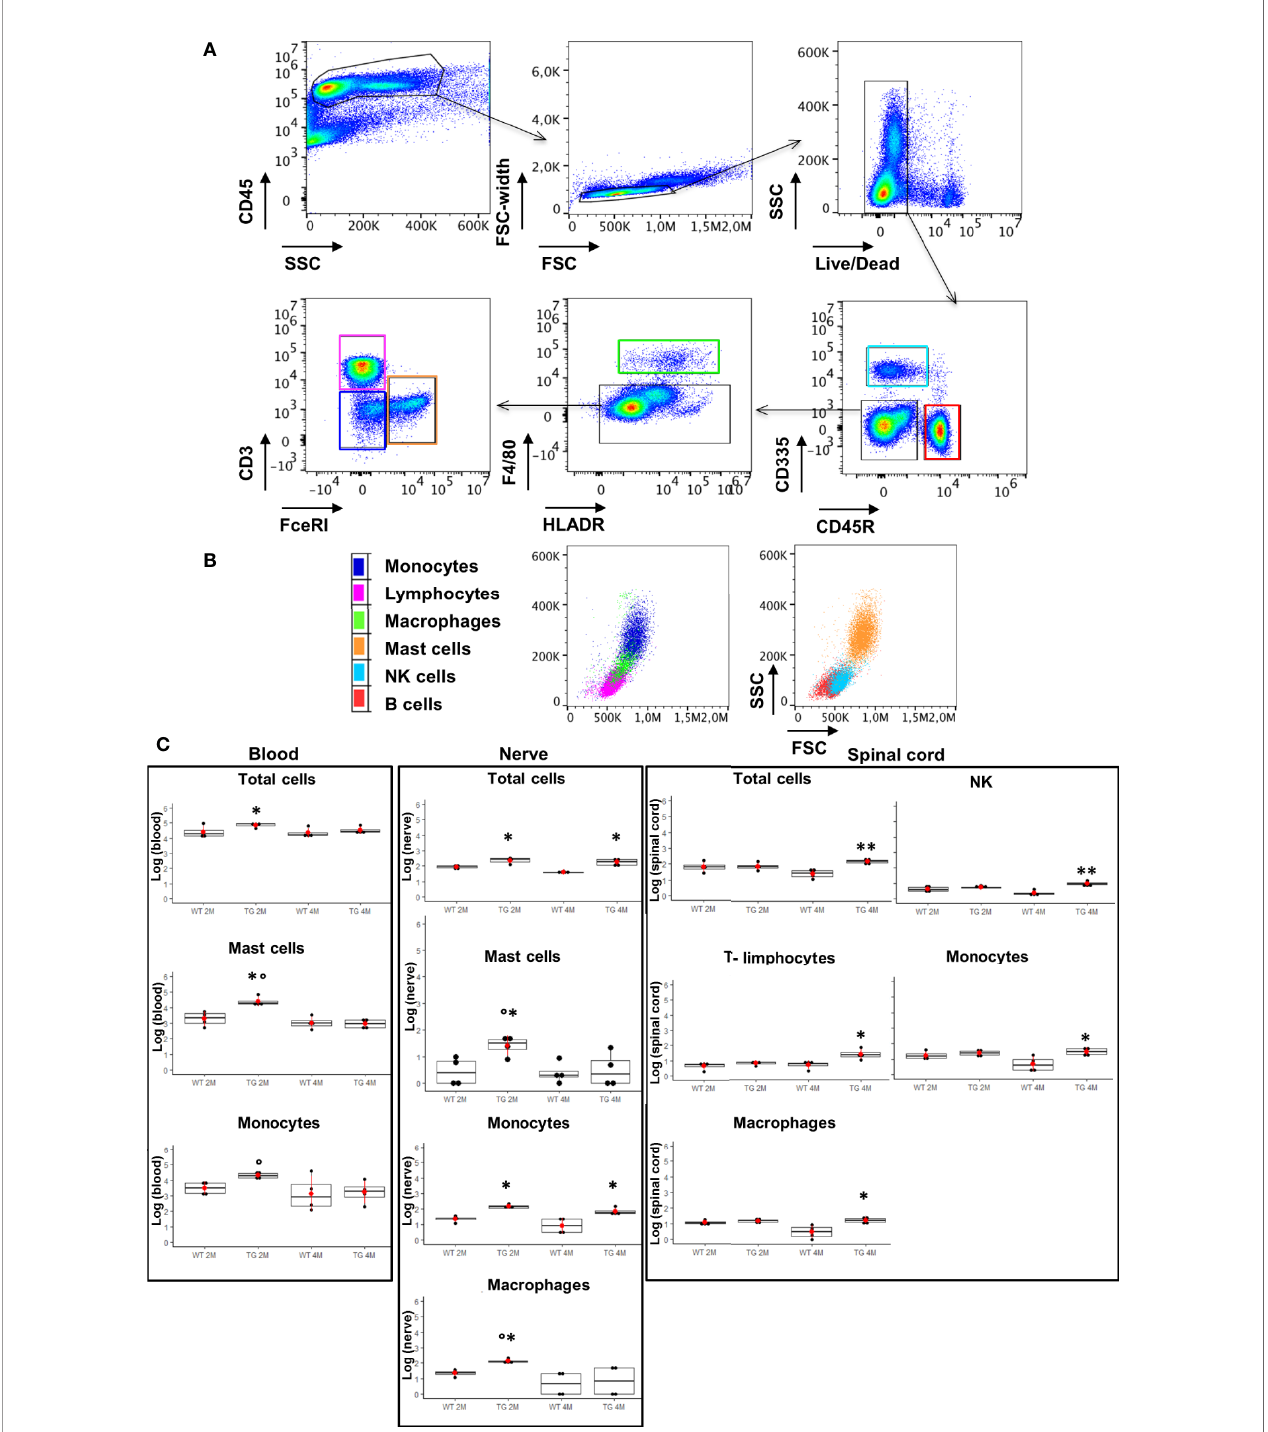
FIGURE 4 | Analysis of CD45 positive cells in blood, sciatic nerve, and spinal cord. (A) , (B) Identi fi cation of hematopoietic origin cells with anti-CD45 antibody; CD45R and CD3 for B and T lymphocytes respectively, CD335 for NK cells, F4/80 and Fc e RI for macrophages and mast cells respectively. Results are expressed in absolute number of cells, CytoFLEX Cytometer uses the sample peristaltic pump to take sample and calibrates sample volume delivery for absolute cell counts without using beads. (C) Graphs show signi fi cant changes (log scale) in circulating immune cells (blood), in sciatic nerve and in spinal cord between wild-type (WT) and SOD1-G93A (TG) mice at the two ages considered ( 2 months – 2M; 4 months – 4M). Mean is the red point and +/- SD added as pointrange. Dunn Test post- hoc, *p < 0.05, **p < 0.001 vs WT; °p < 0.05 vs 4M; 4 experiments/group, each FACS at least 3 different